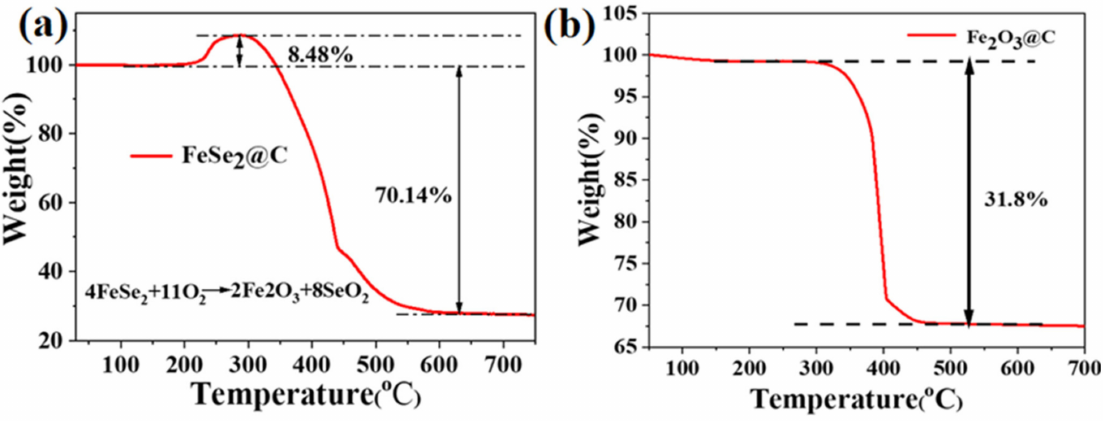
Figure 5. ( a ) TG curve of FeSe2@C composite; ( b ) TG of Fe2O3@C